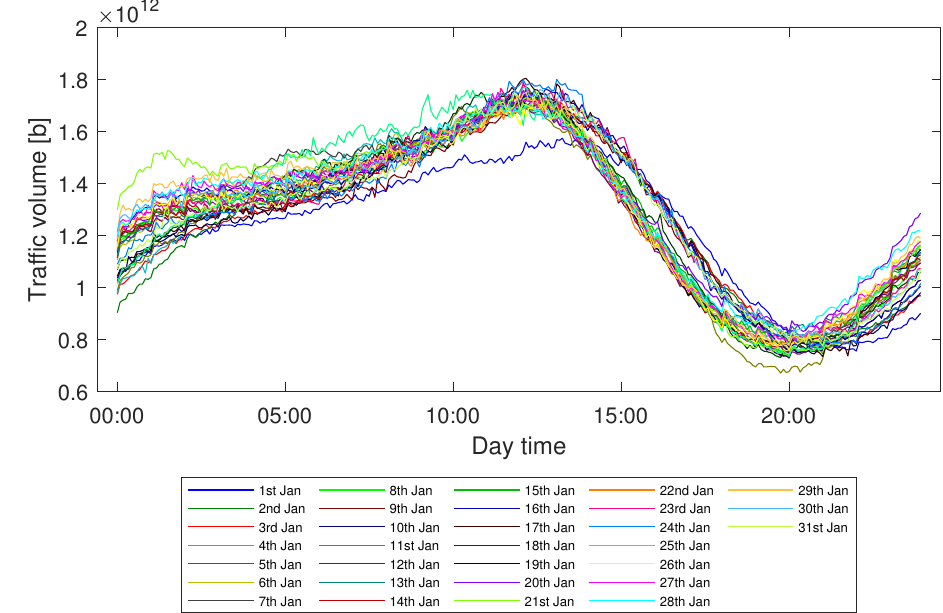
Figure 5. SIX dataset presentation: traffic observed each day in January